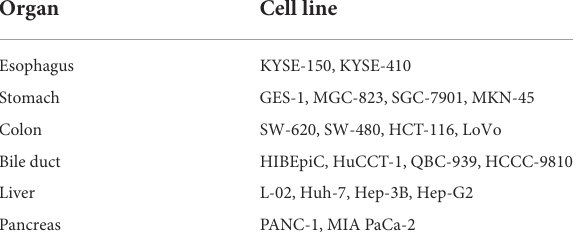
TABLE 1 The information for the cell